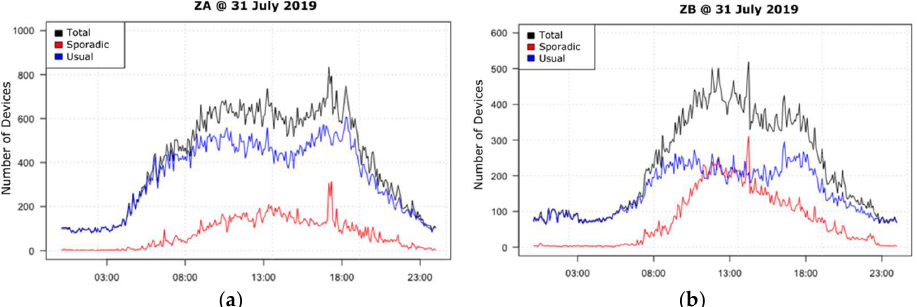
Figure 6. Temporal distribution by device type for 31 July, ( a ) Zone A and ( b ) Zone B.